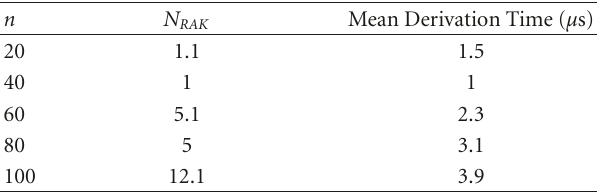
Table 1: Results of simulation